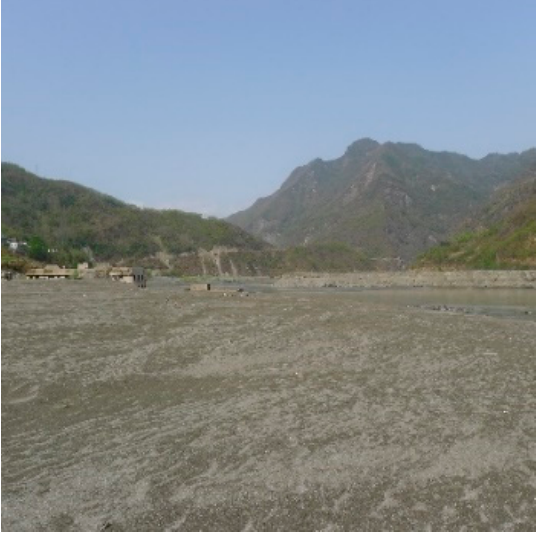
Figure 3. Photo of sampling site A in Figure